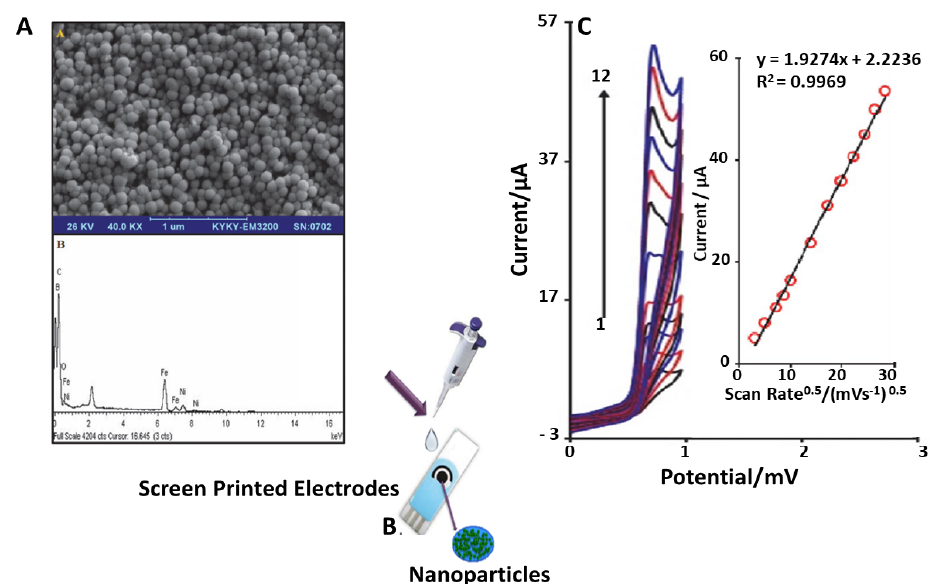
Figure 8. ( A ): SEM Micrograph of NiFe 2 O 4 and its EDX. ( B ): deposition of NPs on SPE with drop casting. ( C ): CVs of NFO/SPE in 0.1 M PBS (pH 7) containing 150 μ M of FA at various scan rates; numbers 1–12 correspond to 10, 25, 50, 75, 100, 200, 300, 400, 500, 600, 700 and 800 mV s − 1 , respectively. Inset: variation of anodic peak current vs. square root of scan rate [64].